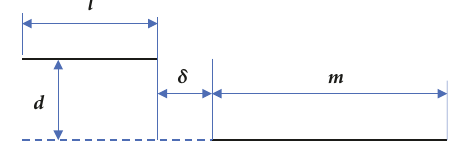
Figure 12: Disposition of two parallel straight conductors.